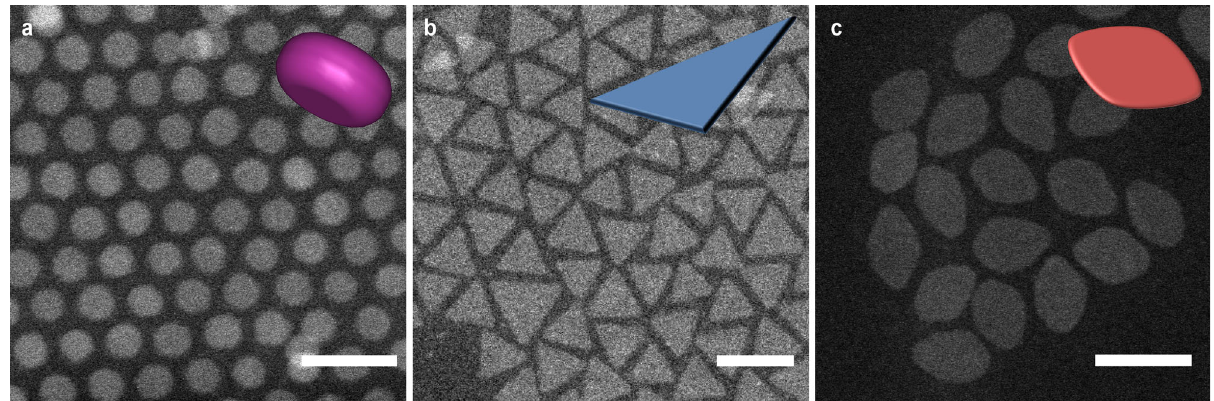
Fig. 1 | Electronmicroscopy imagesandcorresponding schematicillustrations of the shape of LnF 3 NPLs. High-angle annular dark- fi eld scanning transmission electron microscopy (HAADF-STEM) images of a disk-shaped EuF 3 , b triangular